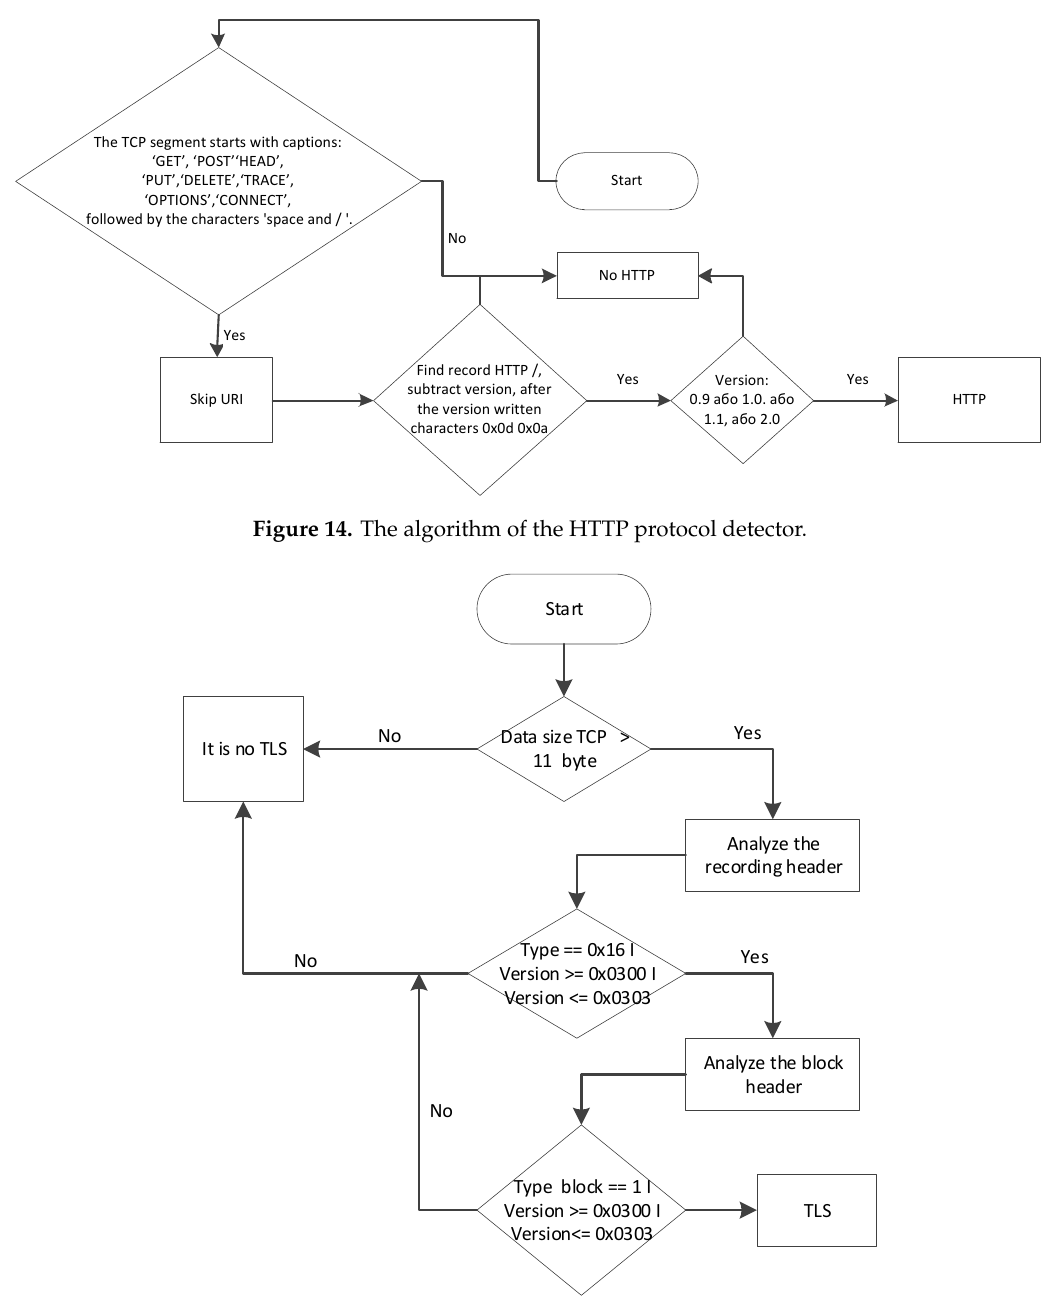
Figure 15. Algorithm for TLS (Transport Layer Security) protocol detection.